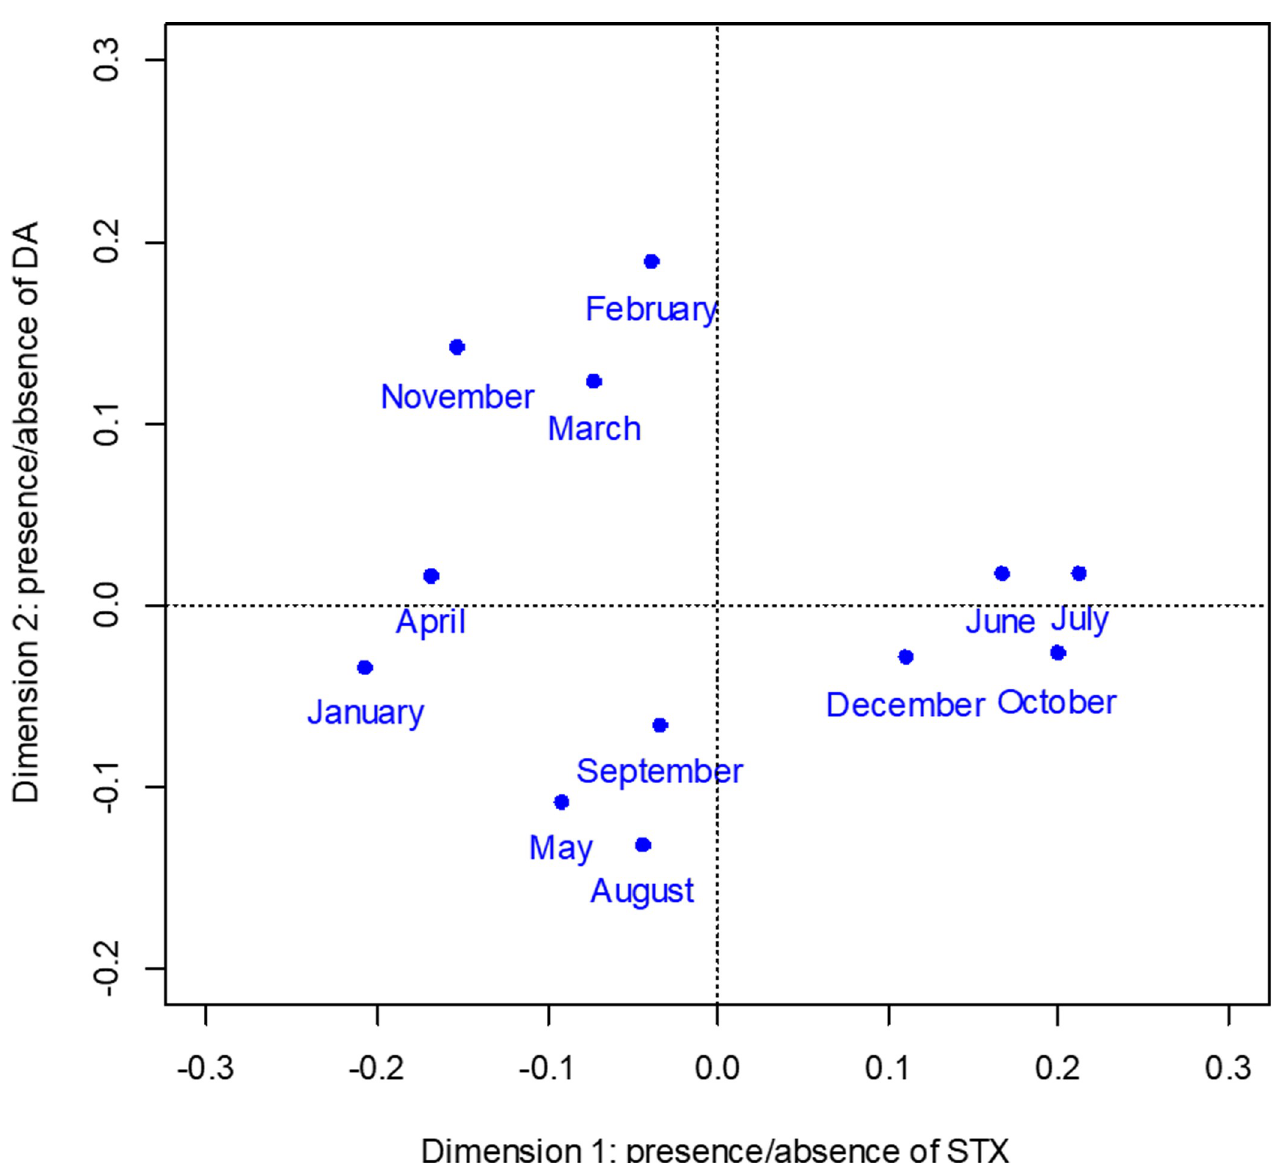
Fig 7. Correspondence analysis ordination for frequency comparisons by month of sampling. Positive values for dimension 1 correlate with larger proportion of positive saxitoxin samples and negative values correlate with larger proportion of negative saxitoxin samples. Positive values for dimension 2 correlated with larger proportion of positive domoic acid samples and negative values correlate with larger proportion of negative domoic acid samples.